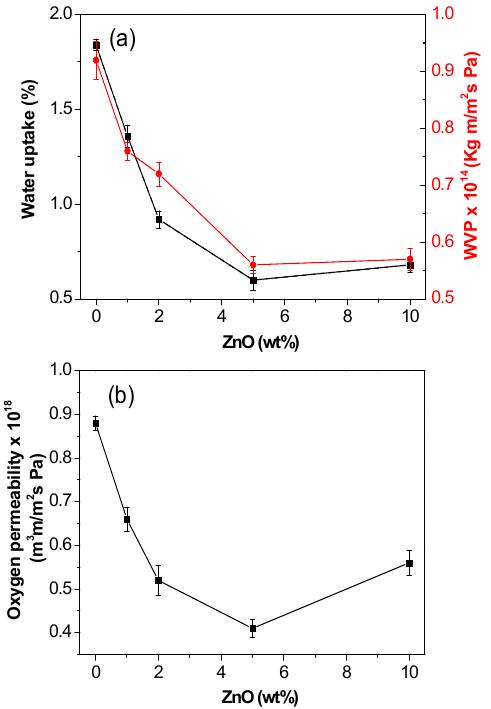
Figure 9. Barrier properties of PHB/ZnO nanocomposites as a function of ZnO